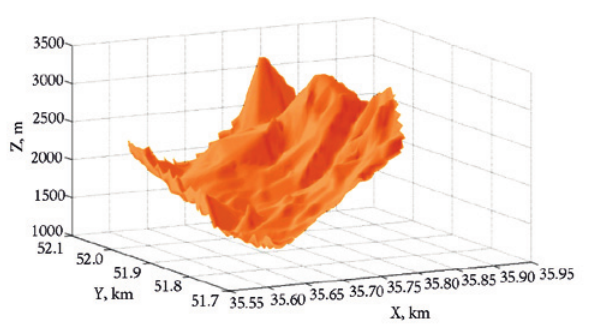
Fig. 17. Result of proposed